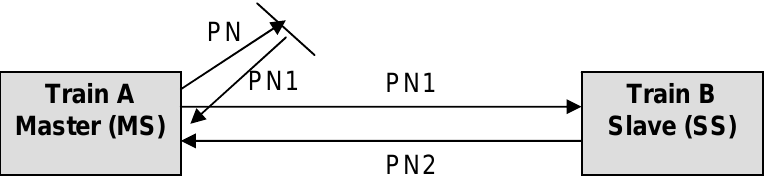
Figure 3. Principle of data transmission and distance measurement based on pseudo- random